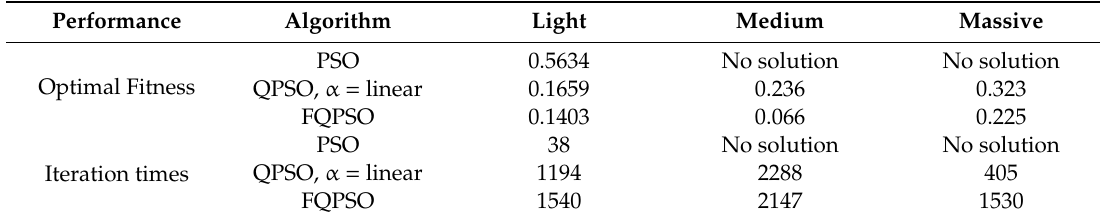
Table 5. The calculated results of minimal fitness by algorithms.